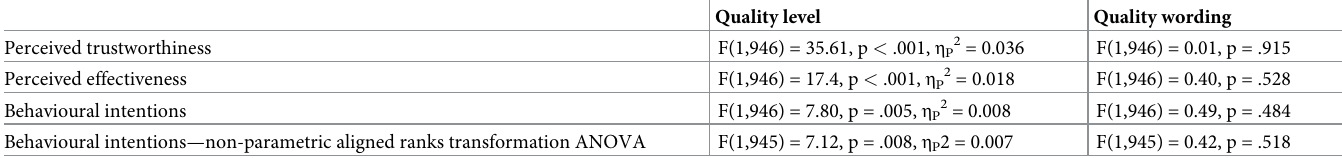
Table 3. Analysis of variance results for all outcome measures (Experiment 1).